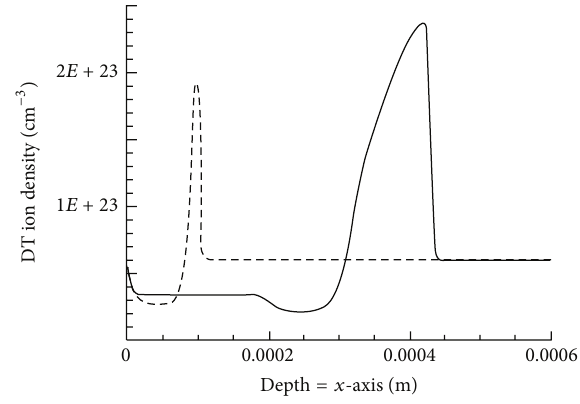
Figure 12: Genuine two fluid hydrodynamic computations [43, 44] of the ion density in solid DT after irradiation of a laser pulse of 10 20 W/cm 2 of PS duration at the times 22 PS (dashed) and 225 PS after the